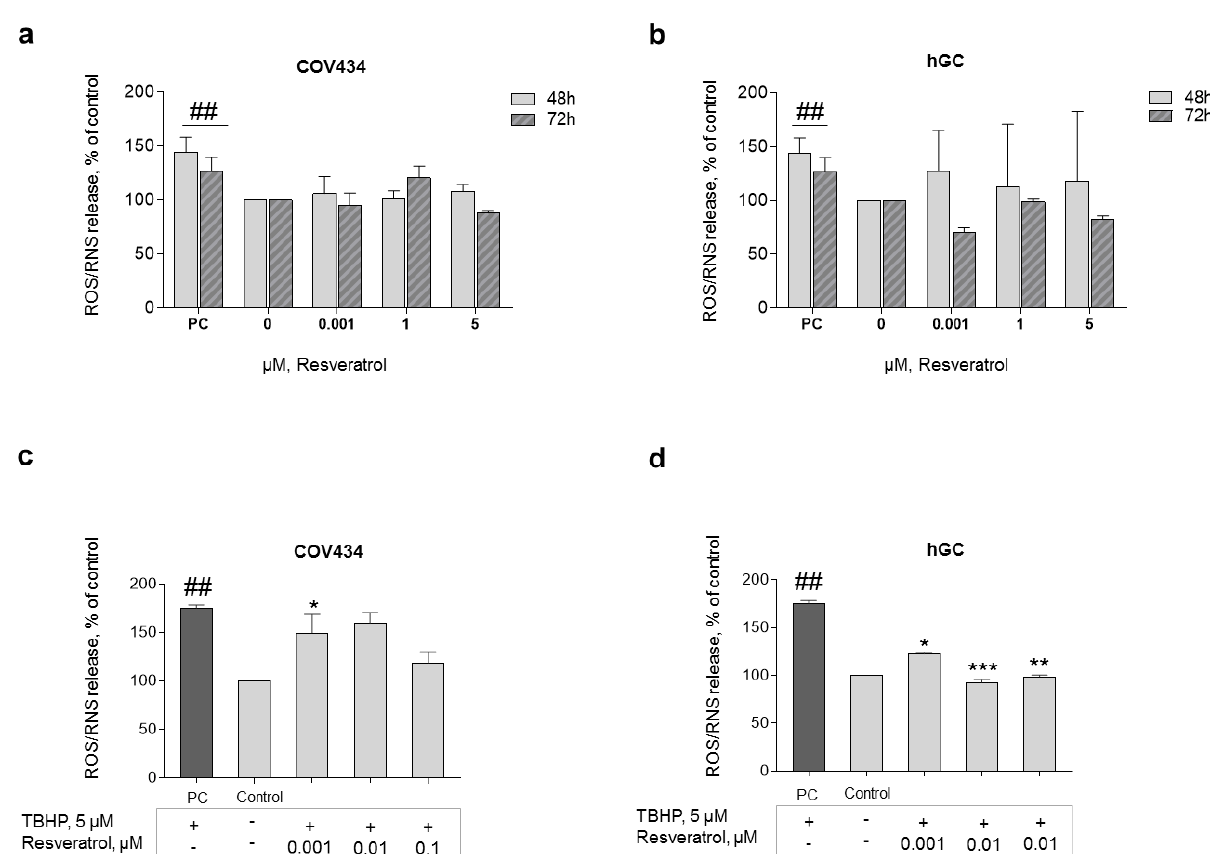
Figure 5. ROS formation after RES addition. The antioxidant capacity of RES was analyzed through the evaluation of ROS production after 48–72 h of treatment with RES (0.001–5 µ M) on COV434 ( a ) and primary hGC ( b ). H 2 O 2 (200 µ M) was used as a positive control (PC). Significant differences between PC and cells treated only with medium (control) are denoted as # ( p < 0.05); ROS production on COV434 ( c ) cells and primary hGC ( d ) treated with RES at different concentrations (0.001–0.1 µ M) for 72 h and then co-treated with 5 µ M of TBHP (using dimethyl sulfoxide (DMSO) as a solvent), assessed by fluorescence assay with DCFH-DA probe. Significant differences between cells treated with TBHP and control (only cell medium) are marked as ## ( p < 0.01). Significant differences between cells treated with TBHP alone and RES treated cells are denoted as * ( p < 0.05), ** ( p < 0.01), and *** ( p < 0.001). Results are expressed as mean ± SEM of three independent experiments performed in triplicate.